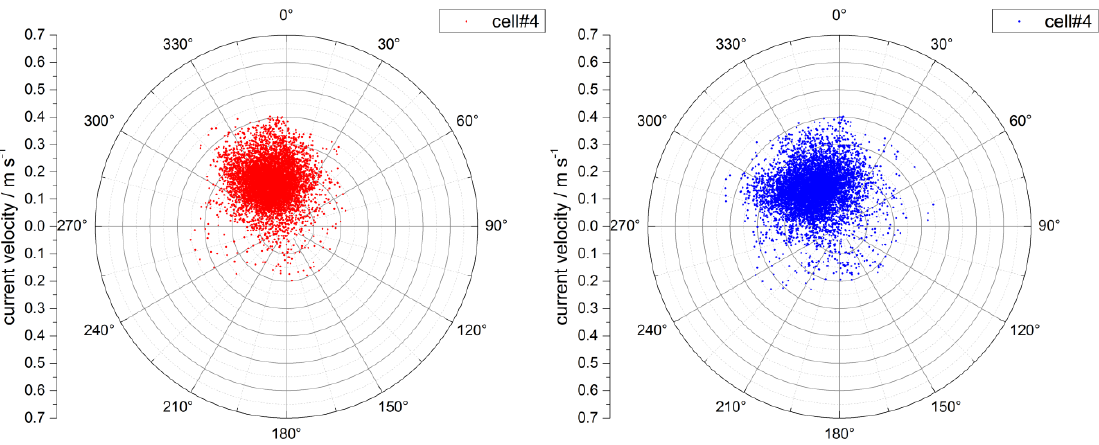
Figure 9. Example of application of the buoy heading correction: current values measured at cell no. 4 before (on the left , in red) and after the correction (on the right , in blue).